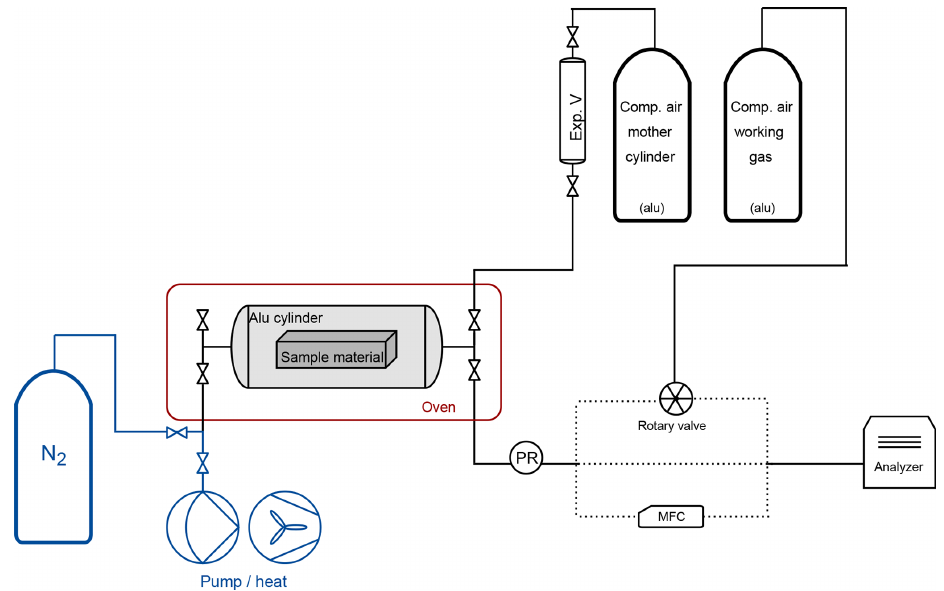
Figure 2. Schematic of the experimental setup. The aluminum cylinder is placed in the oven (denoted by the red box). The cylinder is filled through the expansion volume from the mother cylinder. At the outlet of the cylinder, the dashed lines show the three possible paths into the analyzer: through the rotary valve, direct tubing or mass flow controller (MFC). The equipment related to the cleaning procedure is denoted in